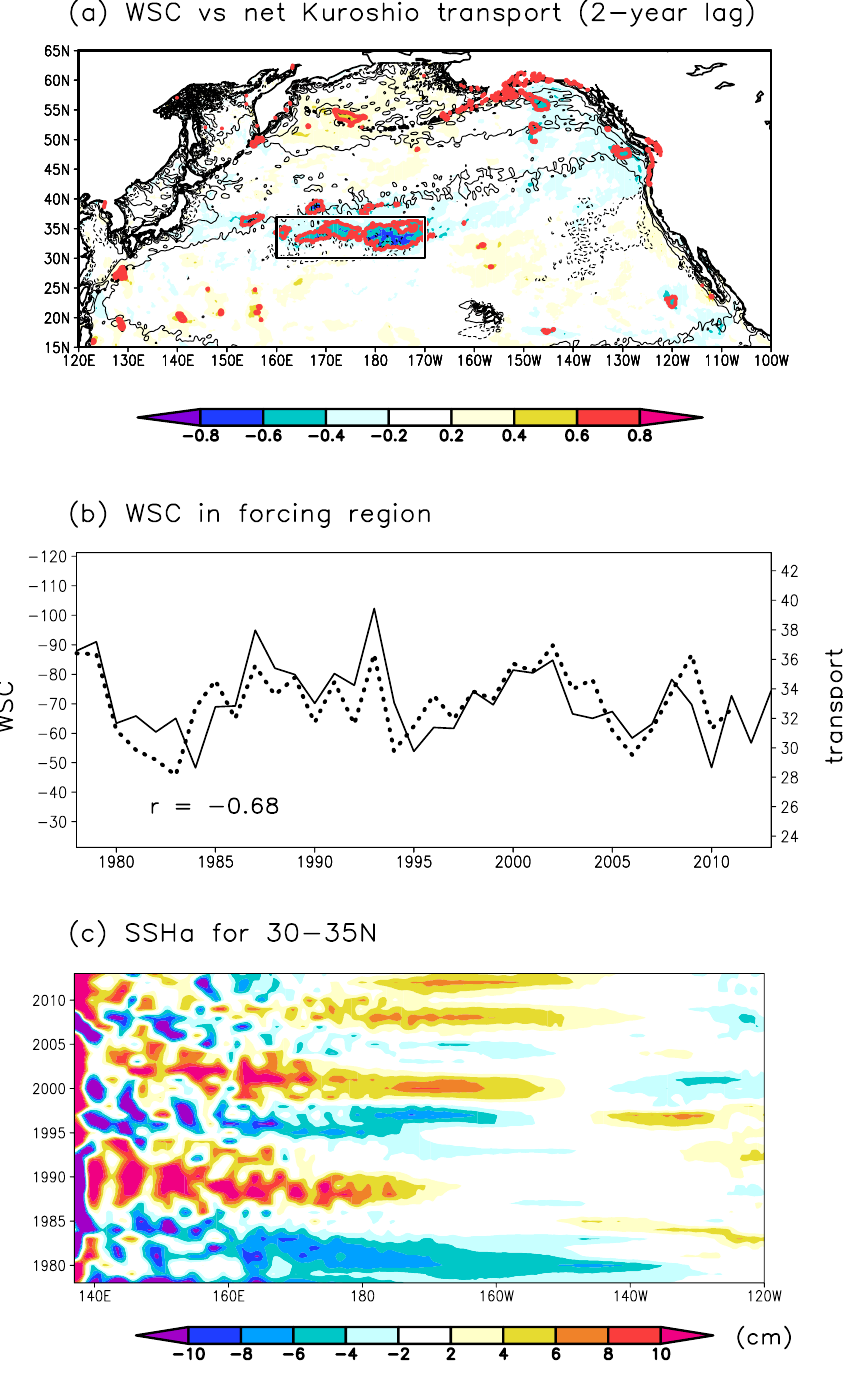
Figure 3. Relationship between the net Kuroshio transport and WSC fields in the North Pacific in the CTRL run. ( a ) Correlation coefficients between WSC and net Kuroshio transport with a 2-year lag (WSC leads net Kuroshio transport). Regions where the significance of the correlation coefficient exceeds the significance level of 0.1 are shown in red. Contours denote the WSC climatology (1978–2013) with 90 × 10 –9 kg m –2 s –2 intervals (negative values are shown by dotted contours). The rectangle indicates the forcing region (30–37°N, 160°E–170°W). ( b ) WSC (10 –9 kg m –2 s –2 ) (left axis) averaged over the forcing region. The dashed line indicates the net Kuroshio transport (Sv) (right axis) in the CTRL run shifted forward by 2 years. The correlation coefficient ( r ) between the two timeseries is shown in the lower left corner. ( c ) Longitude-time diagram of SSH anomalies (cm) averaged over 30–35°N from the CTRL